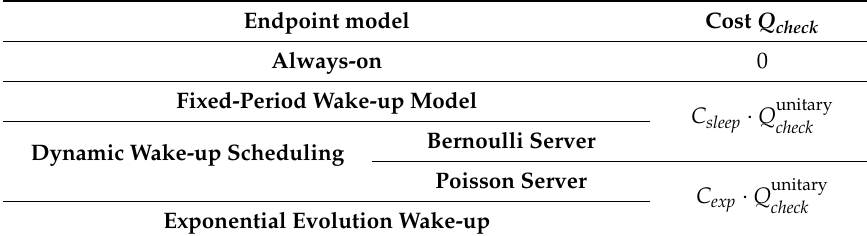
Table 4. Query process cost for di ff erent endpoint’s